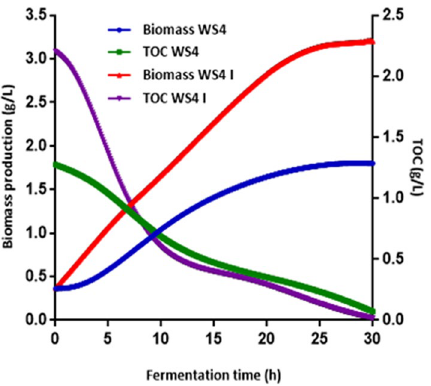
Figure 4. Biomass production and TOC concentration profiles during P. temperata fermentation in WS4 and WS4